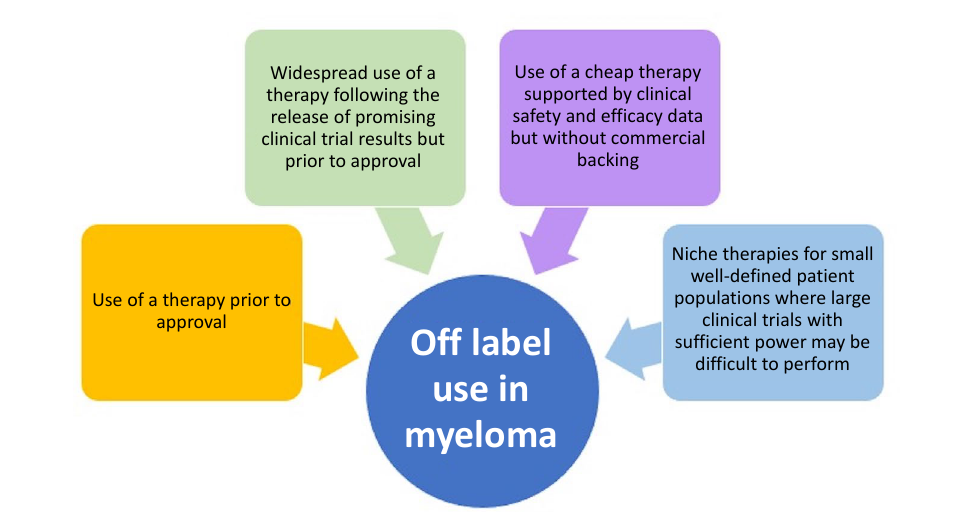
Figure 1. Reasons for off-label drug use in